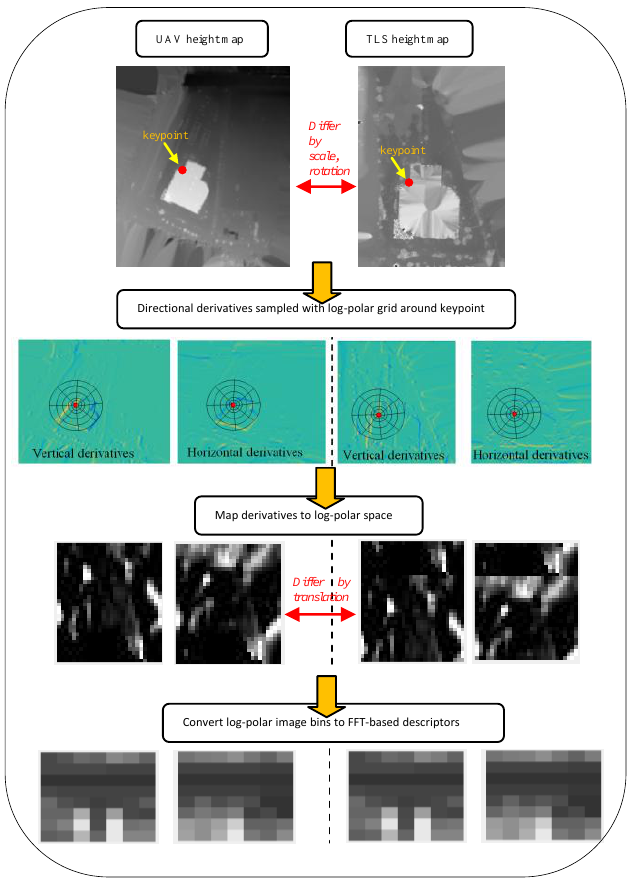
Figure 2. General approach for descriptor